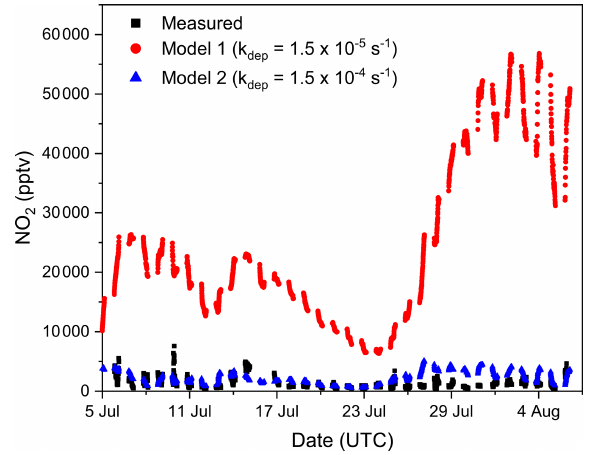
Figure 9. Time series of measured nighttime NO 2 mixing ratios during TO2021 (black squares) and modelled NO 2 mixing ratios using deposition loss constants of 1 . 5 × 10 − 5 s − 1 (model 1; red cir- cles) and 1 . 5 × 10 − 4 s − 1 (model 2; blue